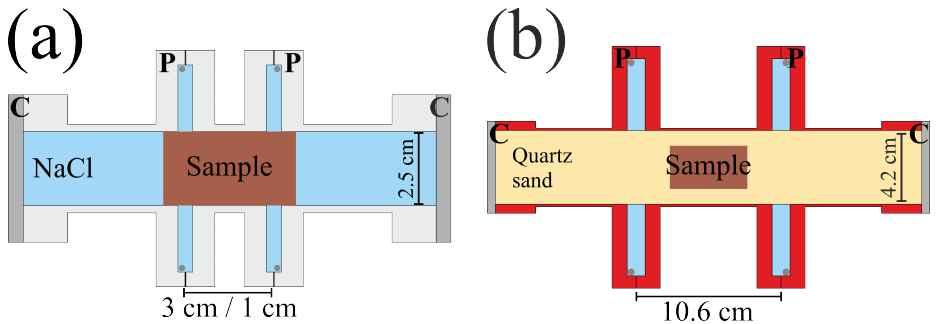
Figure 2. ( a ) Sample holder used to measure cylindrical samples. The stainless steel current electrode plates are marked with C, the nickel silver ring electrodes are denoted by P. The space between electrodes is filled with NaCL solution in blue. Sample holders with two spacings (1 cm and 3 cm) of potential electrodes were used to accommodate samples with different lengths. ( b ) The sample holder for embedded samples. The current and potential electrodes are the same as in ( a ). The sample is embedded in quartz sand and the overall size is larger than in ( a ) to accommodate different sample